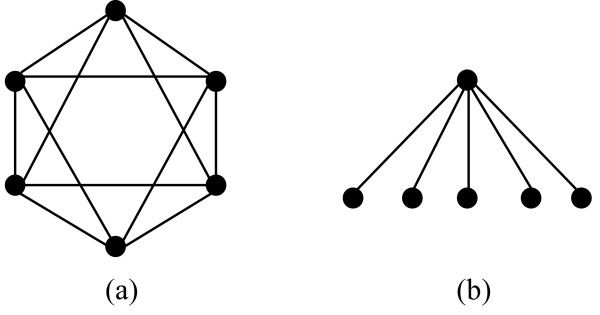
Two examples of graphs with SP = 2. Graphs with the same diameter can have very different topologies. To distinguish different topologies of graphs with the same diameter, we can use the parameter INvK. For example, the two graphs in this figure both have diameter 2. However, for all vertices v in the first graph, the value INvK' is 4/5; while for five of the six vertices in the second graph, the value INvK' is 1/5 (where we define K' = K - v).